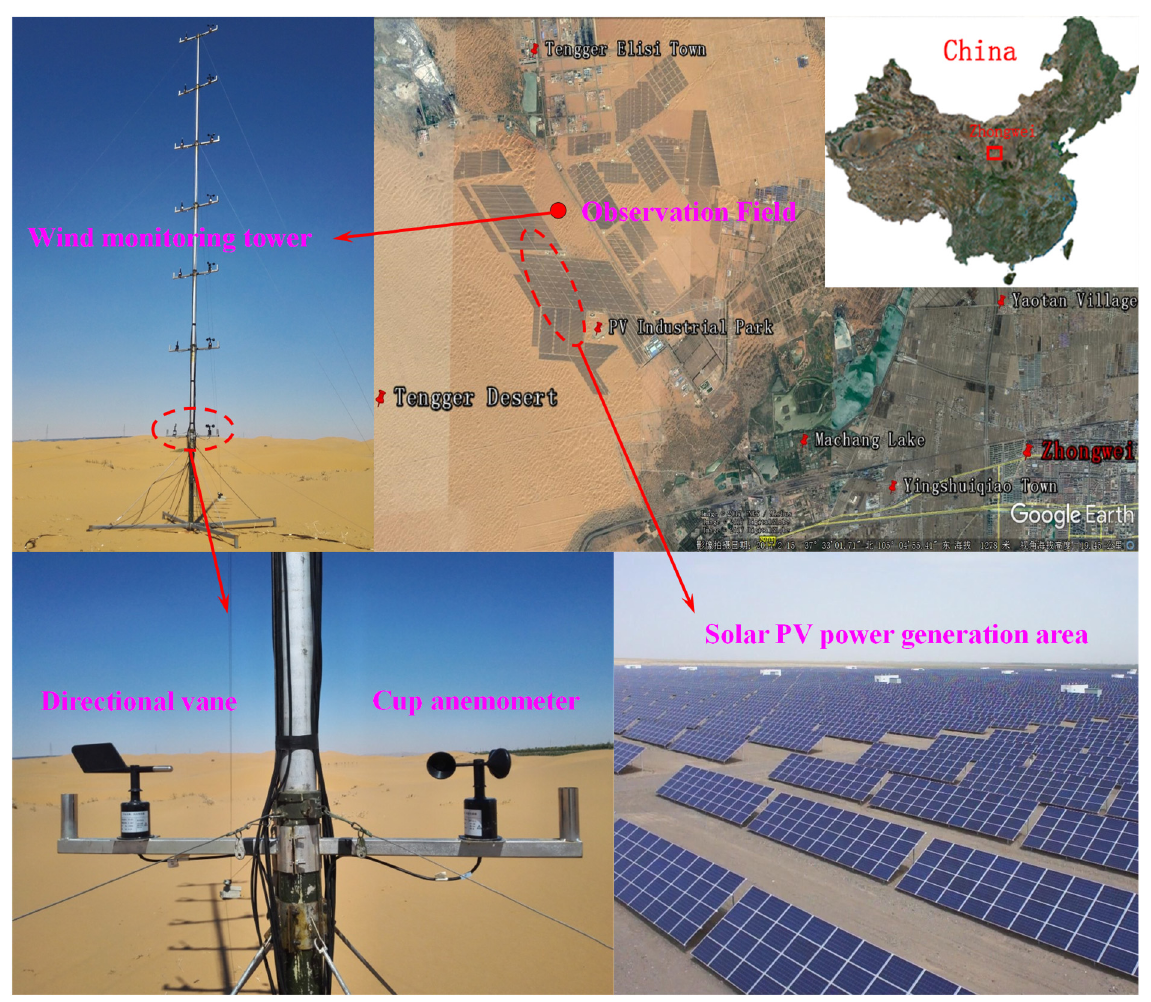
Figure 4. The observation site and the measuring